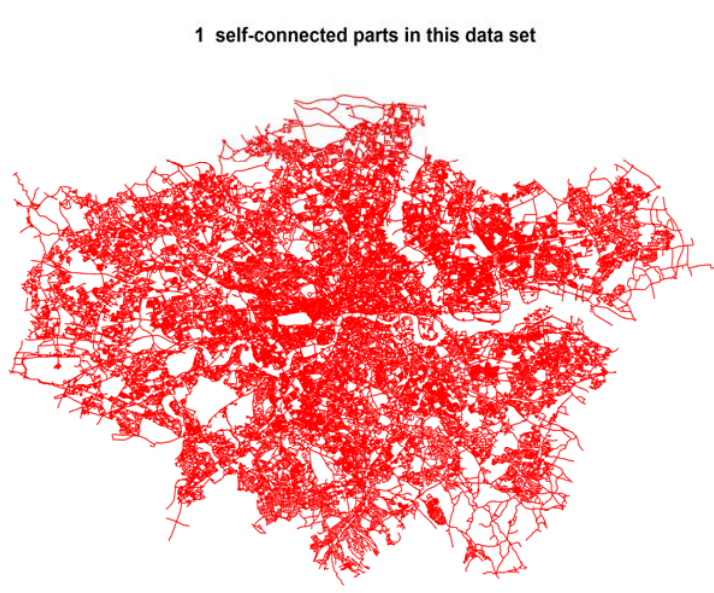
Figure 4. Connectivity of the London road network data via the function nt.connect.